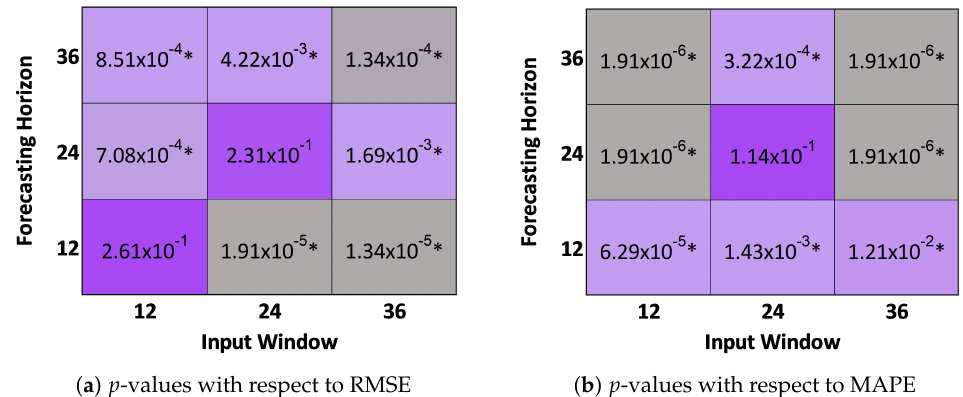
Figure 7. Heatmap of the Wilcoxon test p -values. Statistical significance, where p -value < 0.05, is indicated with